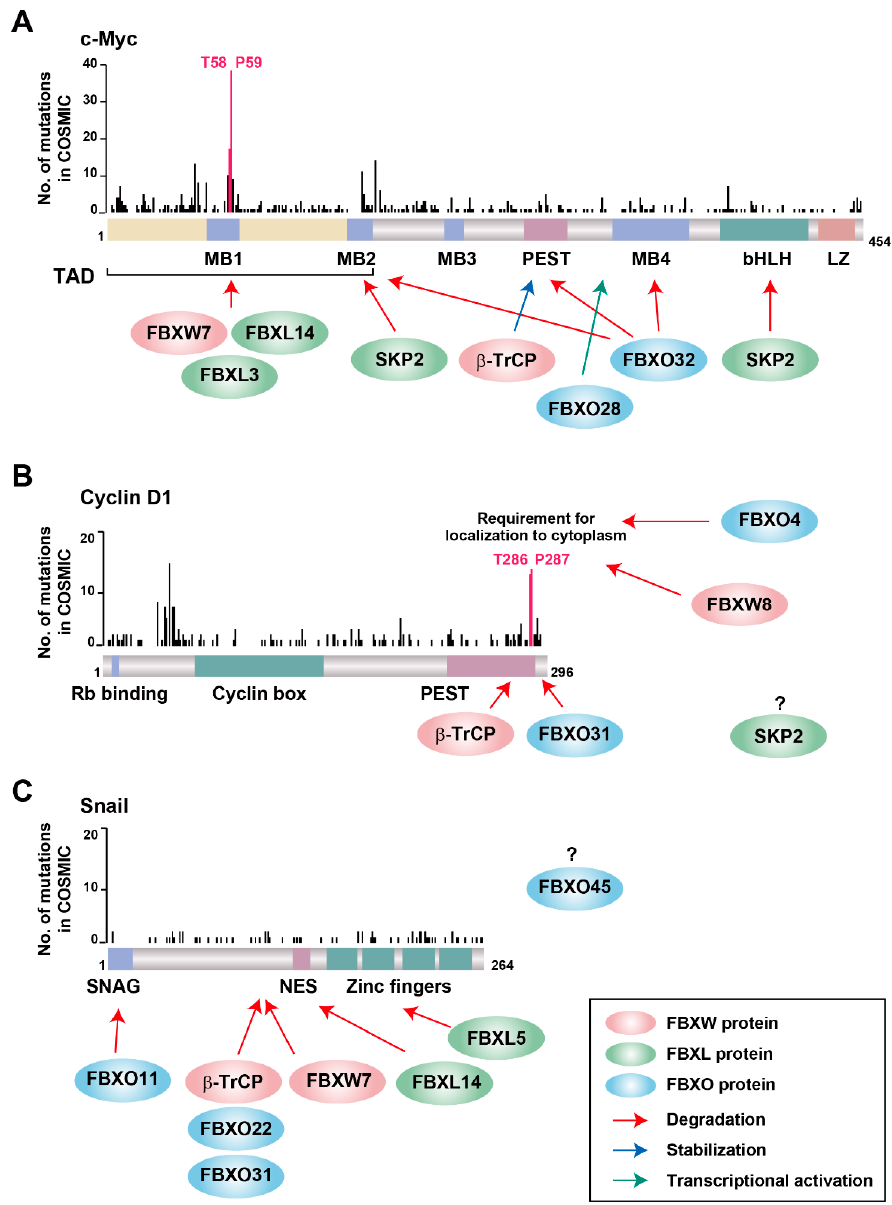
Figure 3. Distribution along the encoded protein sequences of MYC , CCND1 , and SNAI1 mutations identified in the genomes of cancer patients. The numbers of MYC ( A ), CCND1 ( B ), and SNAI1 ( C ) genetic alterations were obtained from the COSMIC database (version 90). Mutations corresponding to critical amino acids for the half-life of c-Myc ( A ) or cyclin D1 ( B ) are shown in pink. Arrows show the recognition sites for F-box proteins and their cofactors.